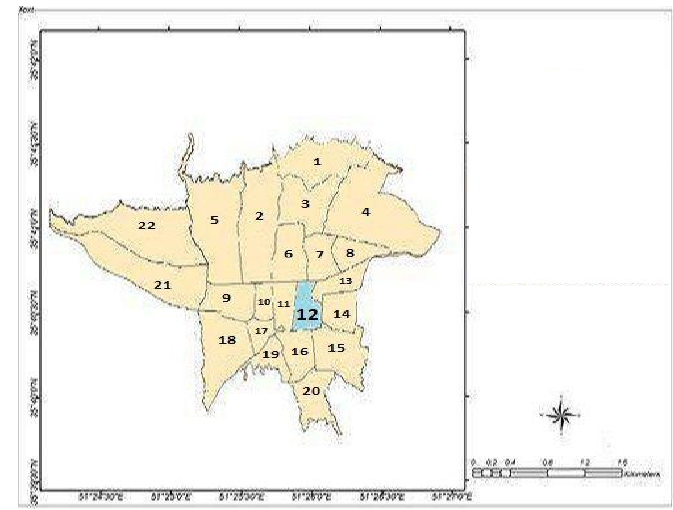
Fig. 2 Location of the District 12 of Tehran Table 2: Site selection variables for fire stations in area 12 of Tehran